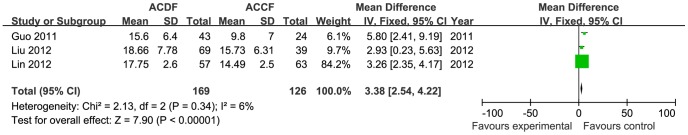
The forest plot for cobb angles of segmental between ACDF group and ACCF group, CI  =  confidence interval, df  =  degrees of freedom, IV  =  independent variable,SD  =  standard deviation.